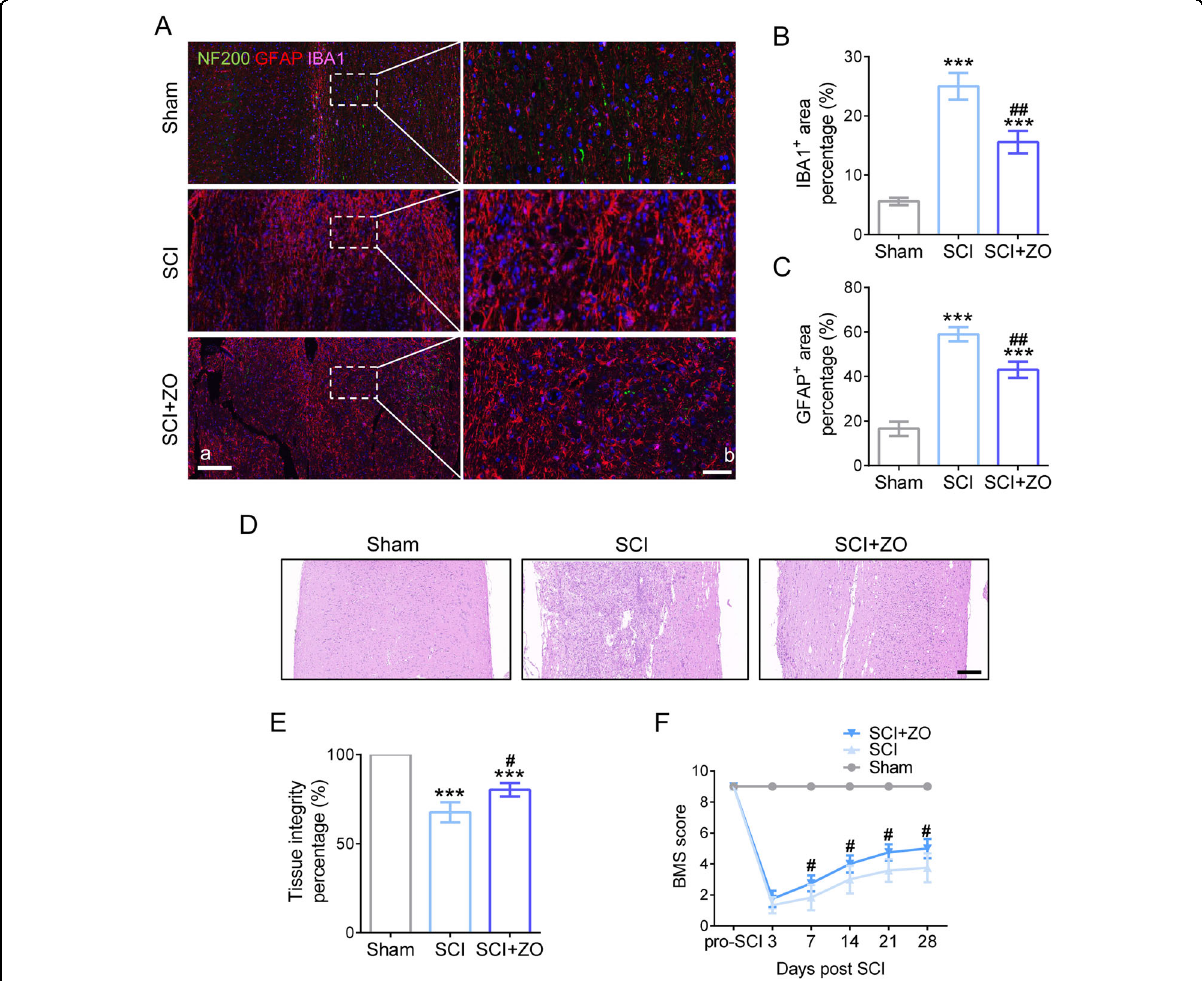
Fig. 5 TAK1 inhibition exerts a bene fi cial effect on histological structure and neurological recovery in SCI mice. A Trinary immuno fl uorescence shows the distribution of NF200 (green), GFAP (red), and IBA1 (pink) in the lesion site of the spinal cord at 28 dpi; a, Scale bar = 200 μ m; b, Scale bar = 50 μ m. B Quanti fi cation of the IBA1-positive area in the spinal cord at 28 days post-SCI. ∗∗∗ P < 0.001 versus Sham group, ## P < 0.01versus SCI group; n = 6 in each group. C Quanti fi cation of the GFAP-positive area in the spinal cord at 28 days post-SCI. D Representative HE staining photos of the spinal cord in Sham, SCI, SCI + ZO group at 28 dpi; Bar scale = 200 μ m. E Quanti fi cation of tissue integrity in the spinal cord. F The BMS score post SCI, # P < 0.05 versus SCI